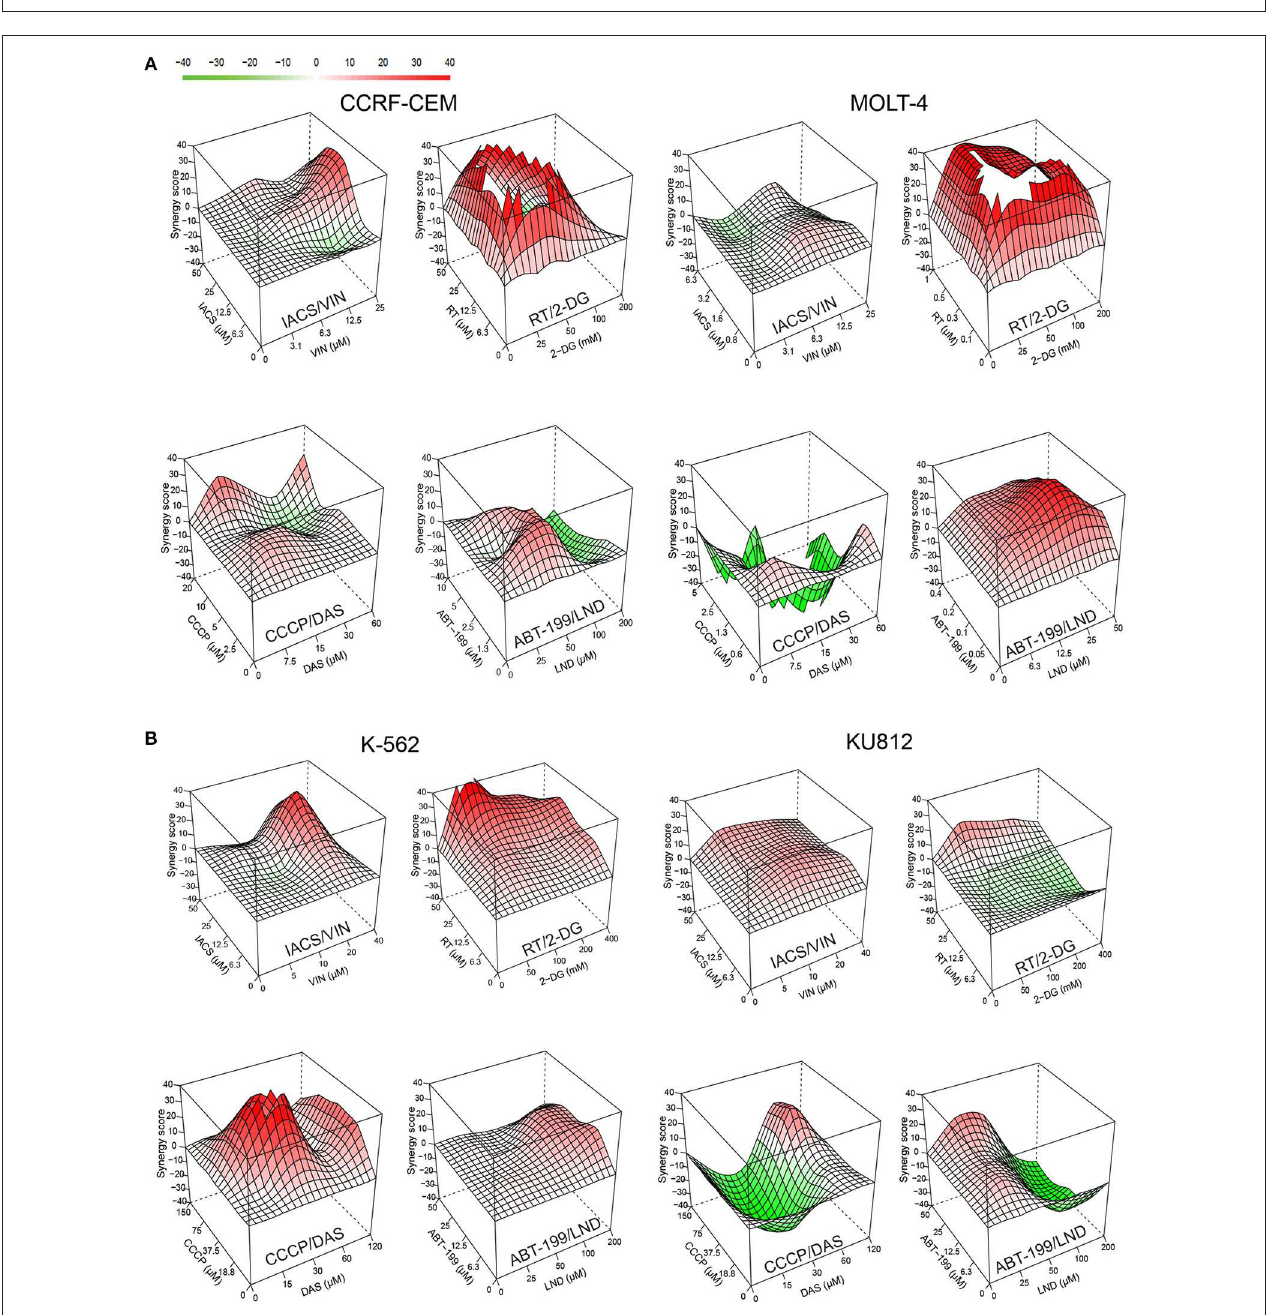
FIGURE 7 | control. Significance of difference vs. PBMCs was assessed via ANOVA with subsequent pairwise comparisons. (E) Significant positive correlation between normalized coupling efficiency, %, and normalized ATP-linked respiration, %, across all studied samples under four selected treatments. (F) Significant negative correlation between normalized levels of ATP, %, and ECAR, %, across all studied samples under four selected treatments. Mito-stress test was repeated three times independently for MOLM-13 cells and PBMCs, and once for each primary AML sample. *** p < 0.001; ** p < 0.01; * p < 0.05; ns: p > 0.05. Correlations were assessed using Pearson r coefficient, line of best fit represents linear regression line.